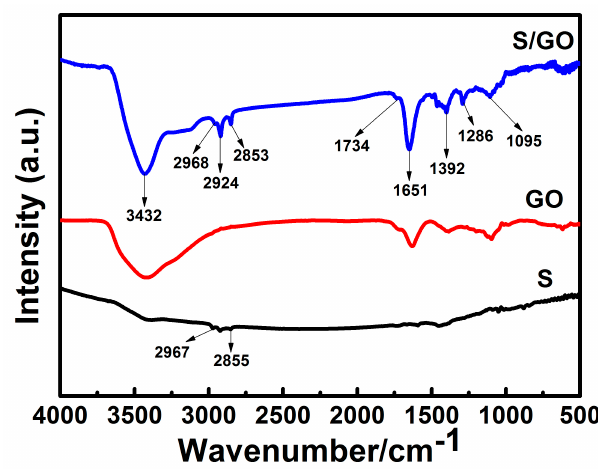
Figure 5. FT-IR spectra of S, GO, and S/GO composite powders.